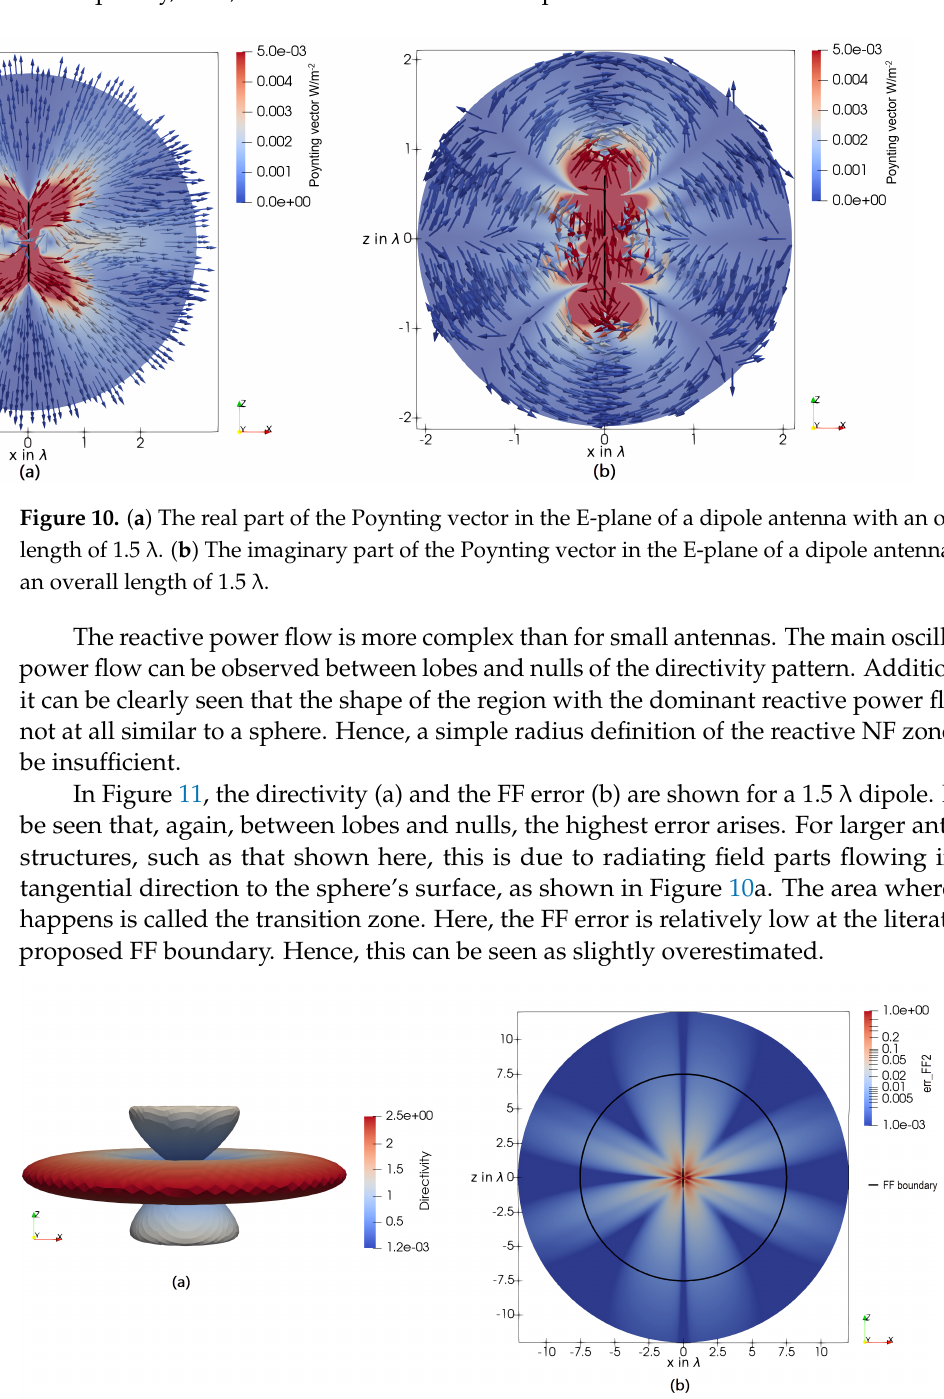
Figure 11. ( a ) A 3D plot of the directivity D ( θ , φ ) of a 1.5 λ dipole. ( b ) The error-estimator 6,